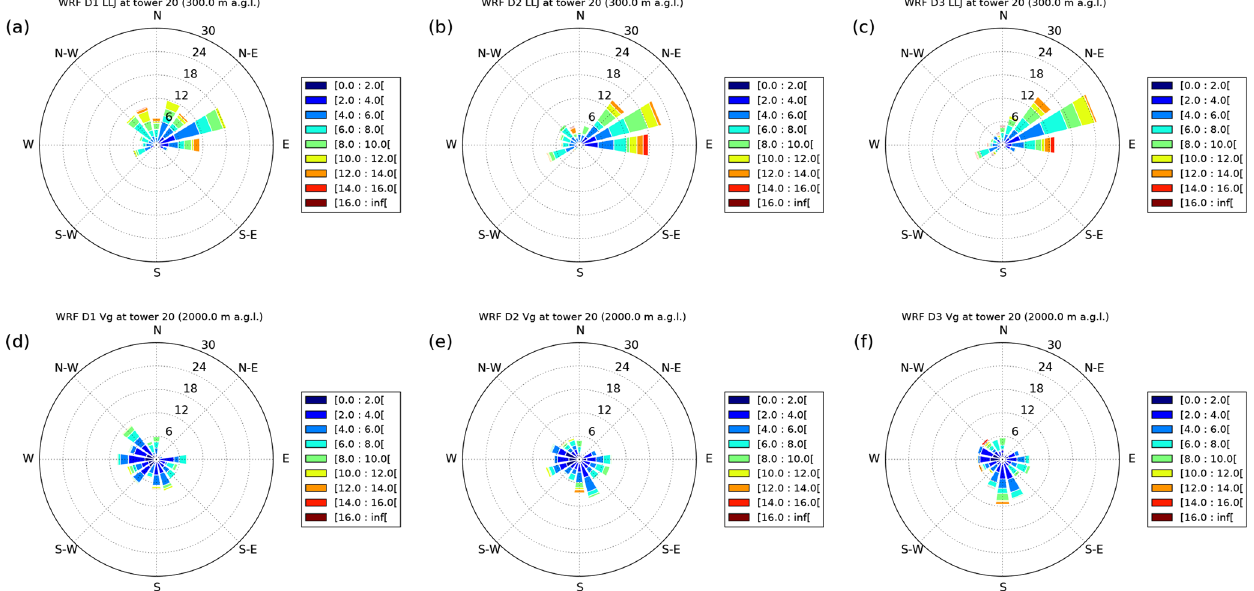
Figure 11. Distribution of winds during LLJ events at (a–c) L 1 (300ma.g.l.) and at (d–f) L 2 (2000ma.g.l.) at the location of tower T20 for domains D1 to D3.